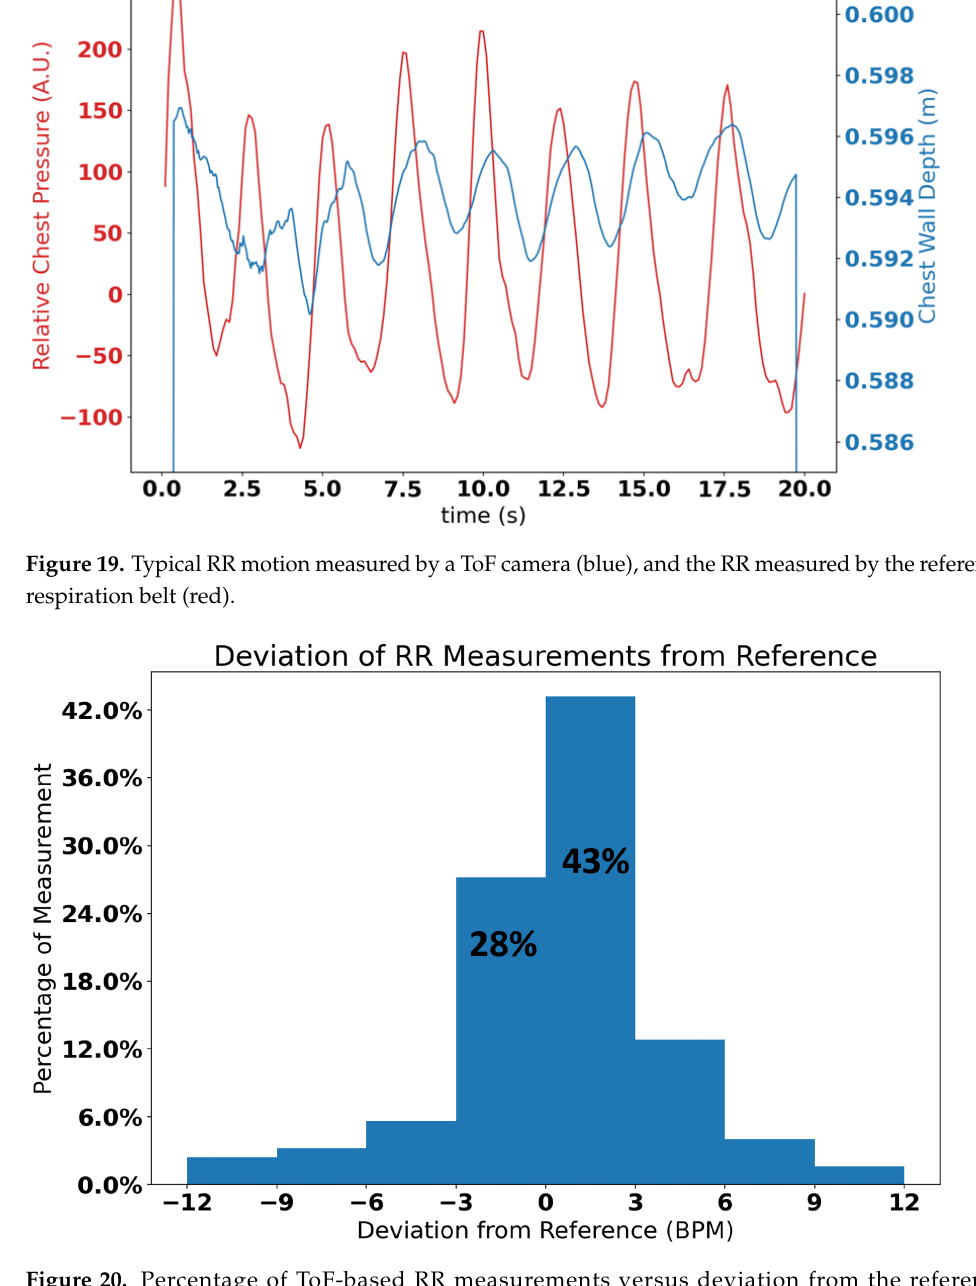
Figure 20. Percentage of ToF-based RR measurements versus deviation from the reference respiration